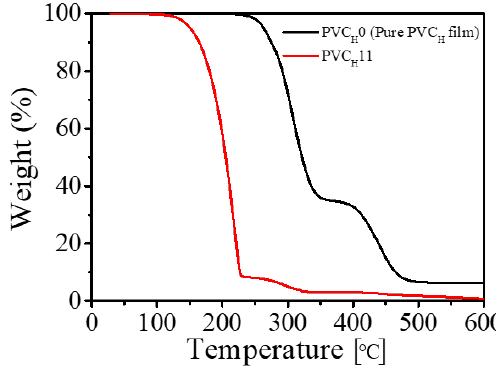
Figure 13. TGA result of the pure PVC film and PVC H 11.